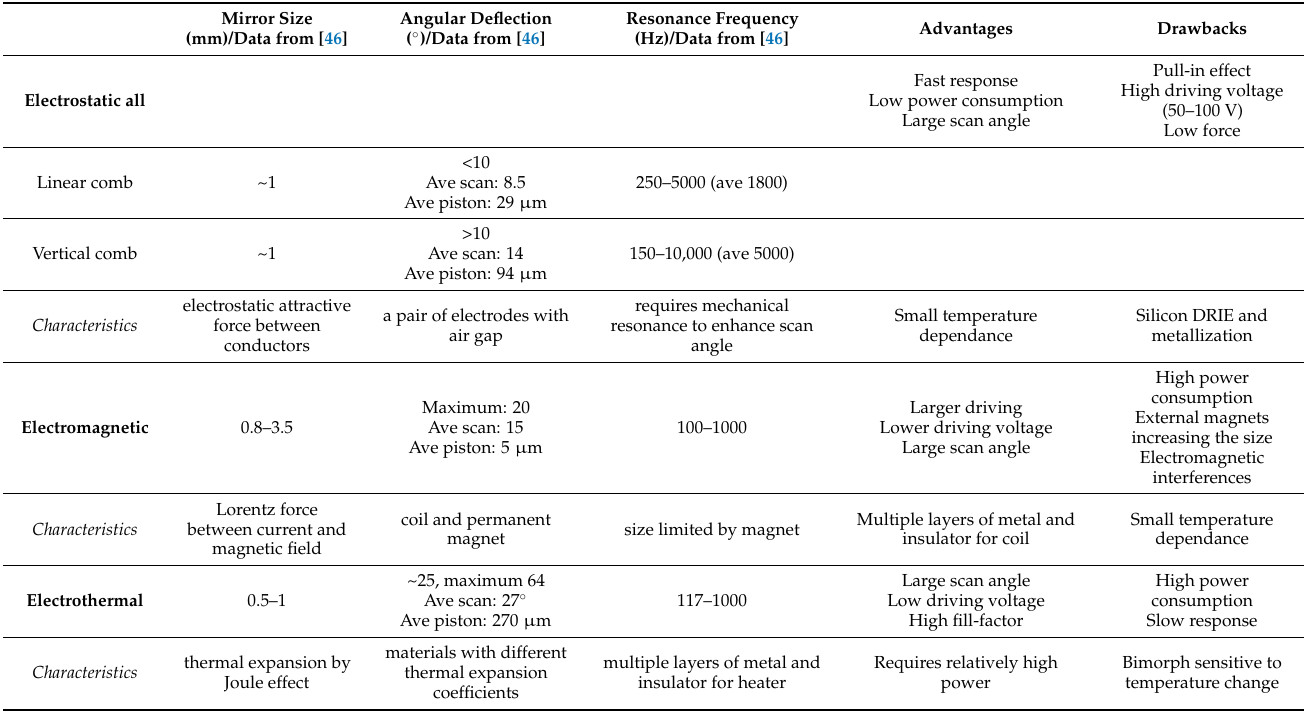
Table 1. Comparison of three main actuation mechanisms used for scanning in OCT